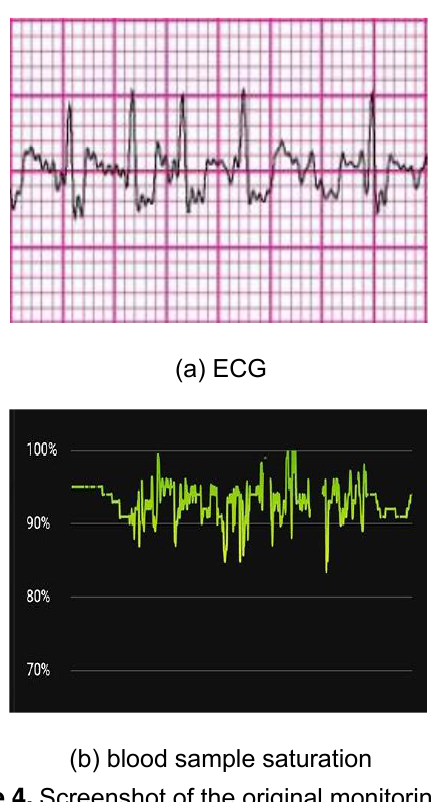
Figure 3. Remote medical video area tampering area detection process